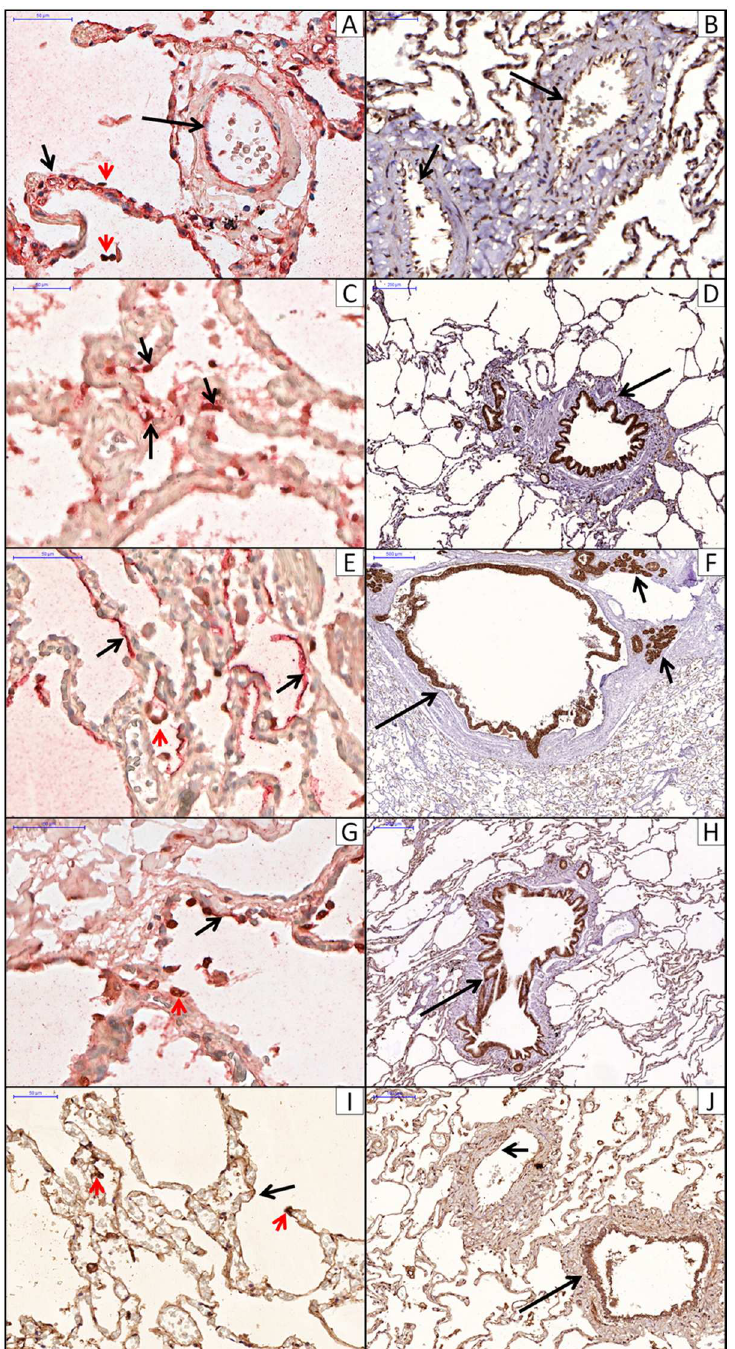
Fig 2. Immunohistochemistry localization of aquaporins, Na-K-ATPasechannel and ENaC channel. A: AQP1 in alveolar(short arrow) and arteriolar(long arrow) endothelialcells. Doublestaining for AQP1 (red) and PII cels (TTF-1, brown, red arrowhead). B: AQP1 in vascular endothelial cells (arrow). C: AQP3 in PII cells (arrows). Doublestaining for AQP3 (red) and PII cels (TTF1, brown). D: AQP3 in epithelialbronchiolar cells (arrow). E: AQP5 in PI cells liningthe alveolarseptum (arrow). Double stainingfor AQP5 (red) and PII cels (TTF1, brown, red arrowhead). F: AQP5 in epithelialbronchiolarcells (long arrow) and submucosal glands(short arrow). G: Na-K-ATPase channelin PI (arrow) and PII (red arrowhead) cells. Doublestaining for Na-K-ATPase channel(red) and PII cels (TTF1, brown). H: ENaC channelin PI cells liningthe alveolar septum (arrow) and PII cells (red arrowhead).I: ENaC channelin epithelialbronchiolarcells (long arrow) and vascular endotelialcells (short arrow). doi:10.1371/journal.pone.0166184.g002 PLOS ONE | DOI:10.1371/journal.pone.0166184 November11,